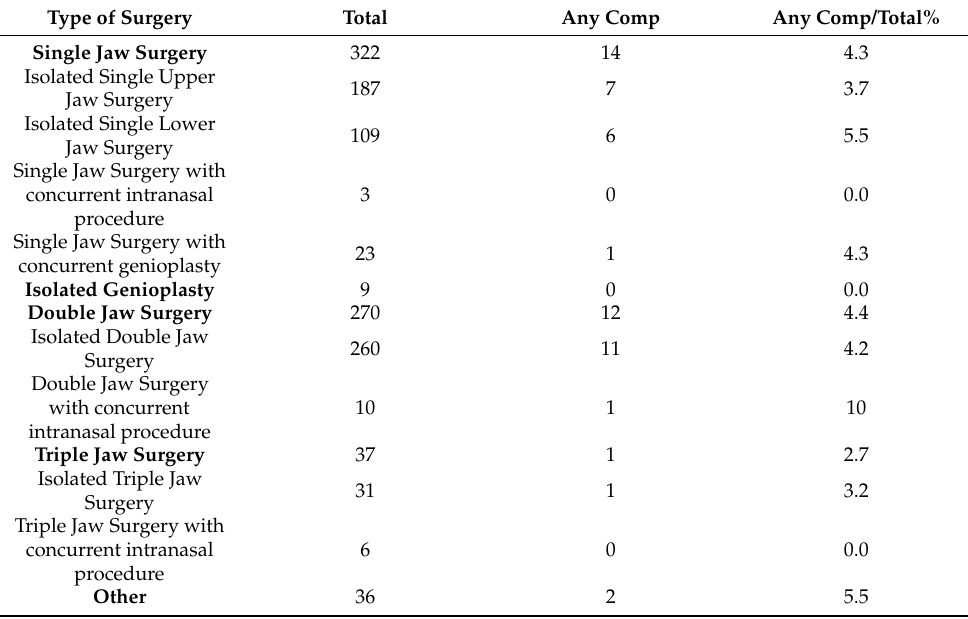
Table 5. Distribution of procedures with the type-specific occurrence of any